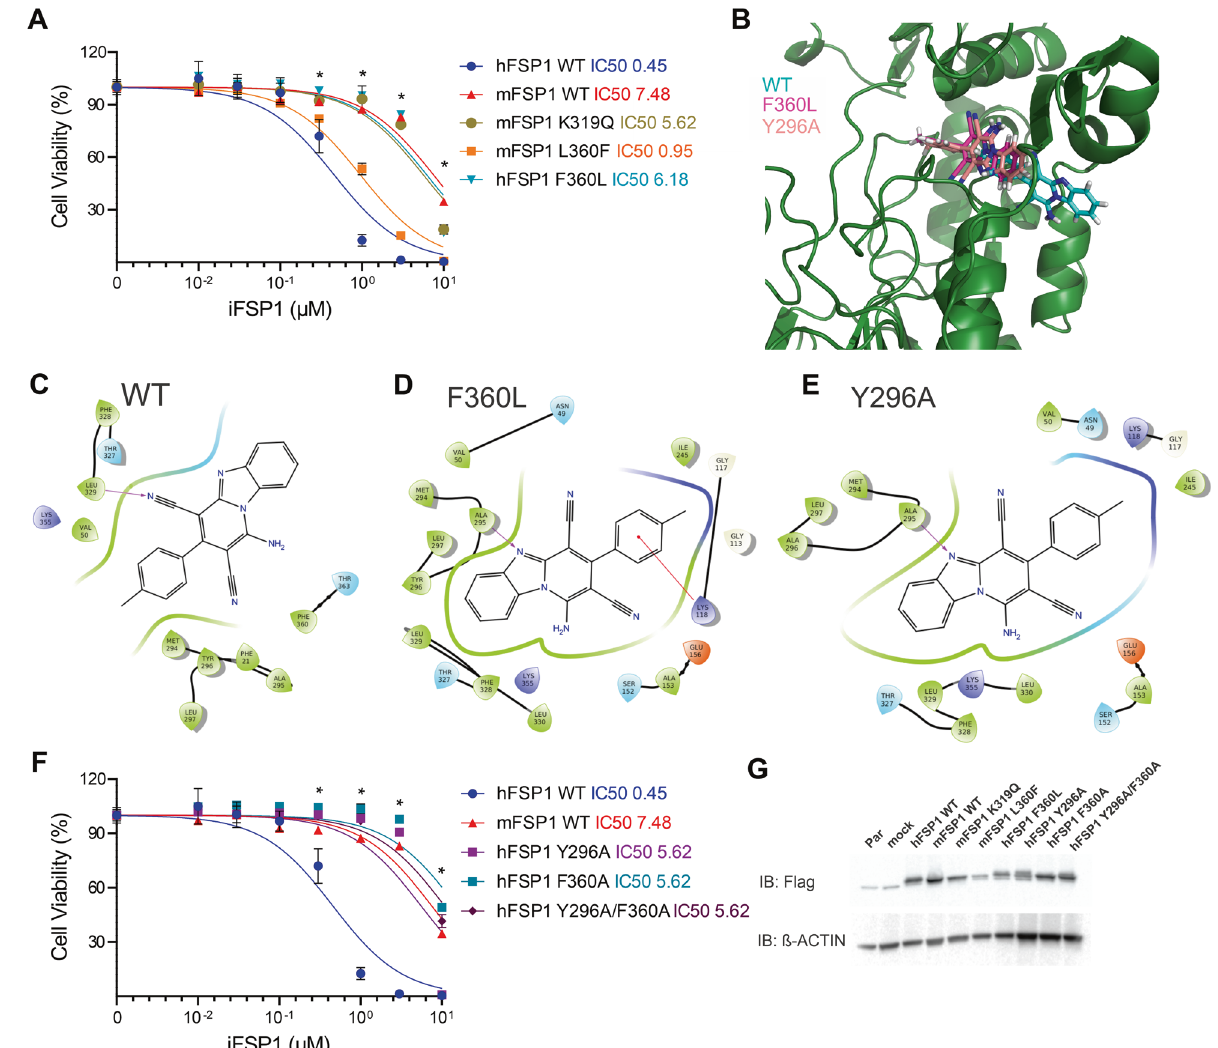
Fig. 2 F360 of FSP1 is essential for iFSP1 target engagement. A Dose-response toxicity to iFSP1 in Pfa1 Gpx4 − / − overexpressing hFSP1, mFSP1 and single point mutants (mFSP1 K319Q , mFSP1 L360F and hFSP1 F360L ). B Binding modes for iFSP1 obtained from docking the ligand to hFSP1 WT or to different mutants. The backbone of hFSP1 WT is represented in green. Cyan: iFSP1 bound to hFSP1 WT, dark pink: iFSP1 bound to mutants F360L or F360I, light pink: iFSP1 bound to mutants Y296A or F360I/Y296A. Only one FSP1 structure (hFSP1 WT) is represented. Interaction diagrams between iFSP1 and hFSP1 WT ( C ), mutant F360L ( D ) and mutant Y296A ( E ). Purple arrows indicate hydrogen bonds. F Dose-response toxicity to iFSP1 in Pfa1 overexpressing hFSP1, mFSP1 and the mutants hFSP1 Y296A , hFSP1 F360A and hFSP1 Y296A/F360A . G Immunoblot analysis of fl ag-tag, GPX4 and FSP1 in Pfa1 Gpx4 − / − overexpressing hFSP1, mF SP1 and mutants. Cell viability data was monitored using Alamar blue. Data are presented as mean ± s.d. of n = 3 wells of a 96-well